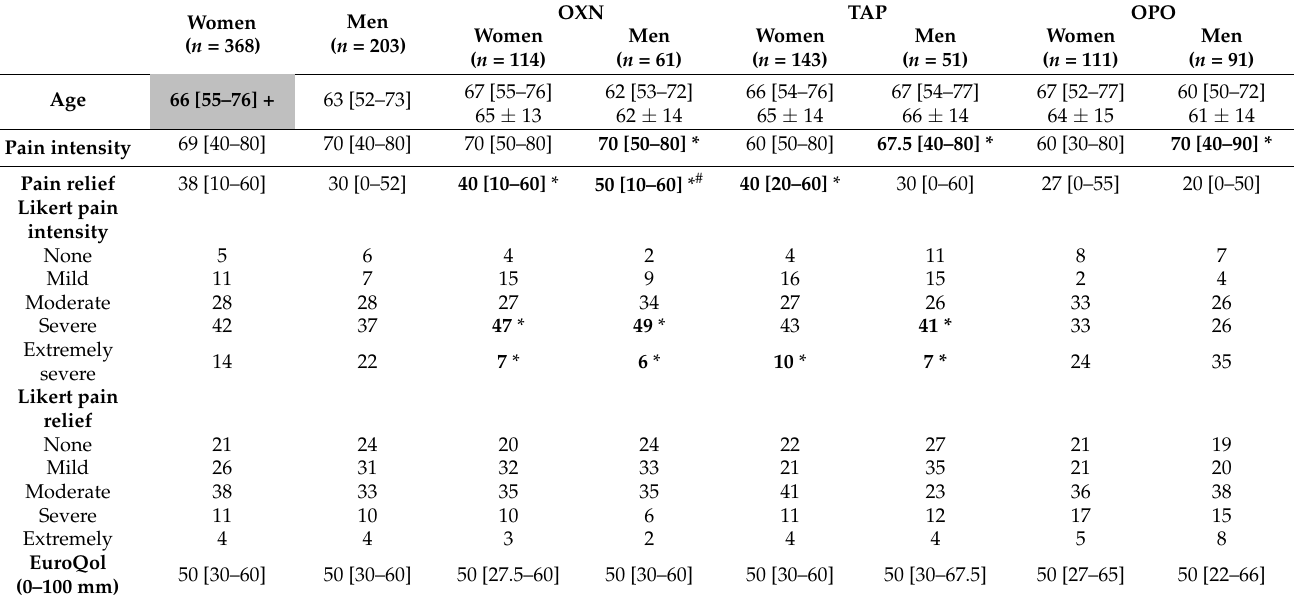
Table 1. Demographic, clinical, and pharmacological data of women and men of the total